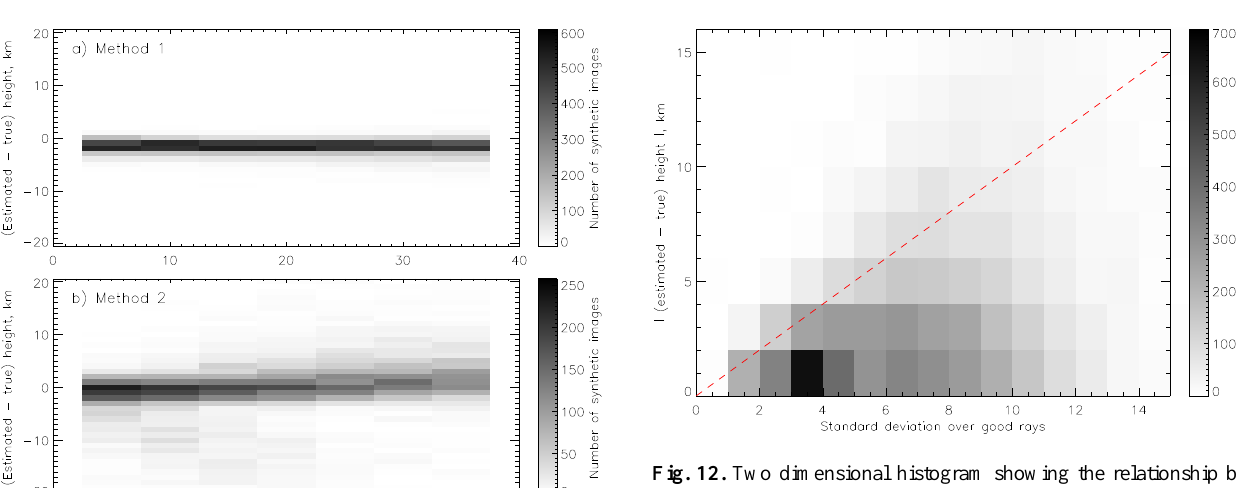
Fig. 12. Two dimensional histogram showing the relationship between the standard deviation of the peak height over all field lines which contribute to the average emission profile in method 2 and the difference between the true peak height and the height estimated by the method. Fig. 11. The effect of the auroral arc width on the performance of (a) method 1 and (b) method 2.